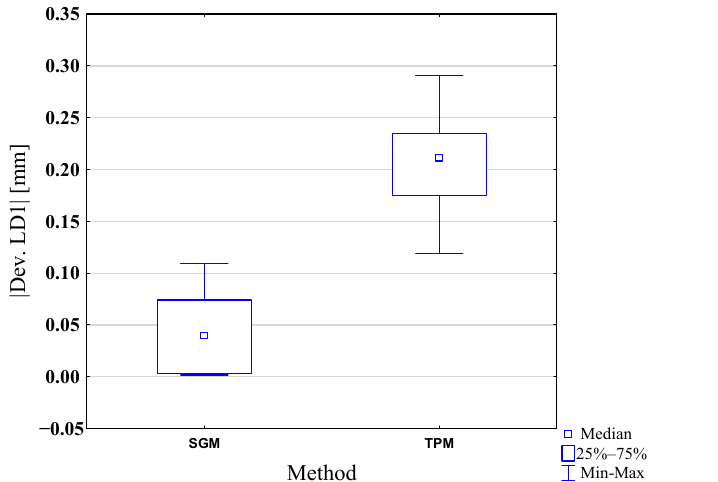
Figure 5. Comparison of deviations of the linear dimension 3 for SGM and TPM methods.